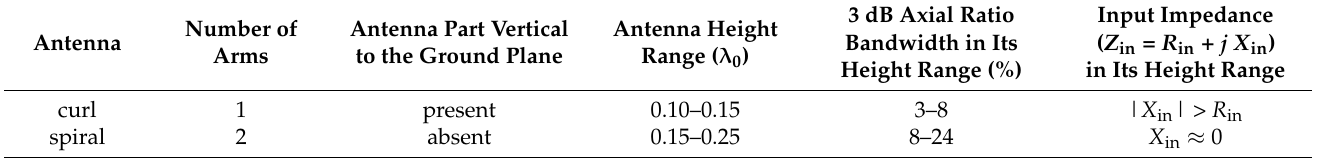
Table 1. Differences between curl and spiral